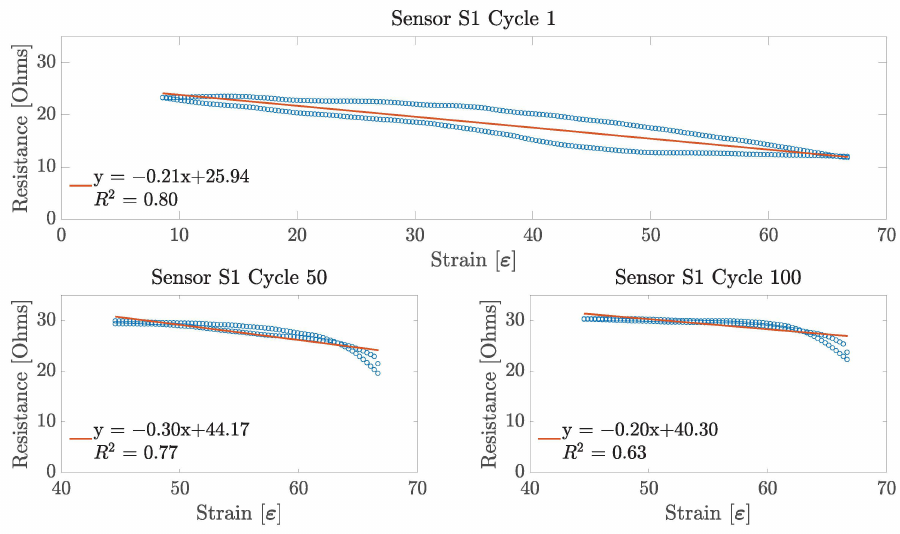
Figure 12. Linearity results for Sensor S1. Linearity data from Cycle 1 are shown over a 7.5–66% work- ing range, whereas linearity data from Cycles 50 and 100 are shown over a 40–66% working